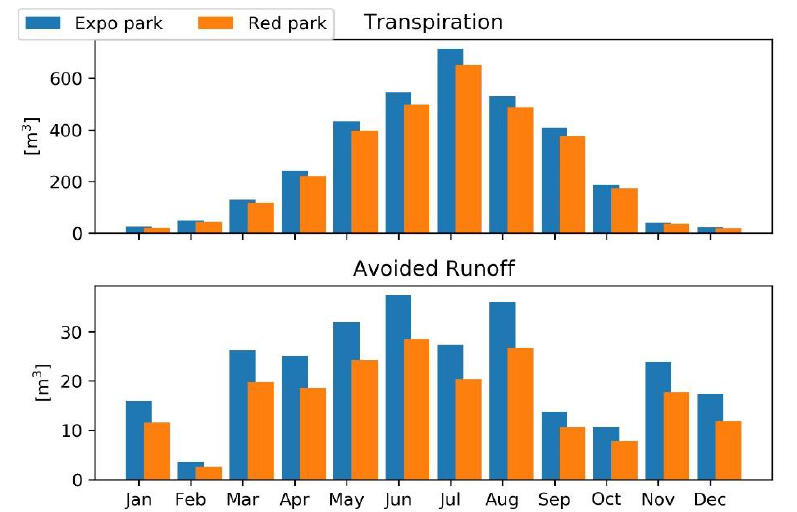
Figure 7. Monthly transpiration and avoided runoff by trees in EXPO and RED Park of Tbilisi in 2018.